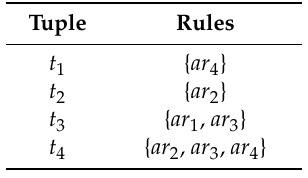
Table 15. Sets of di ff erent tuple_rules ( t ) for sod